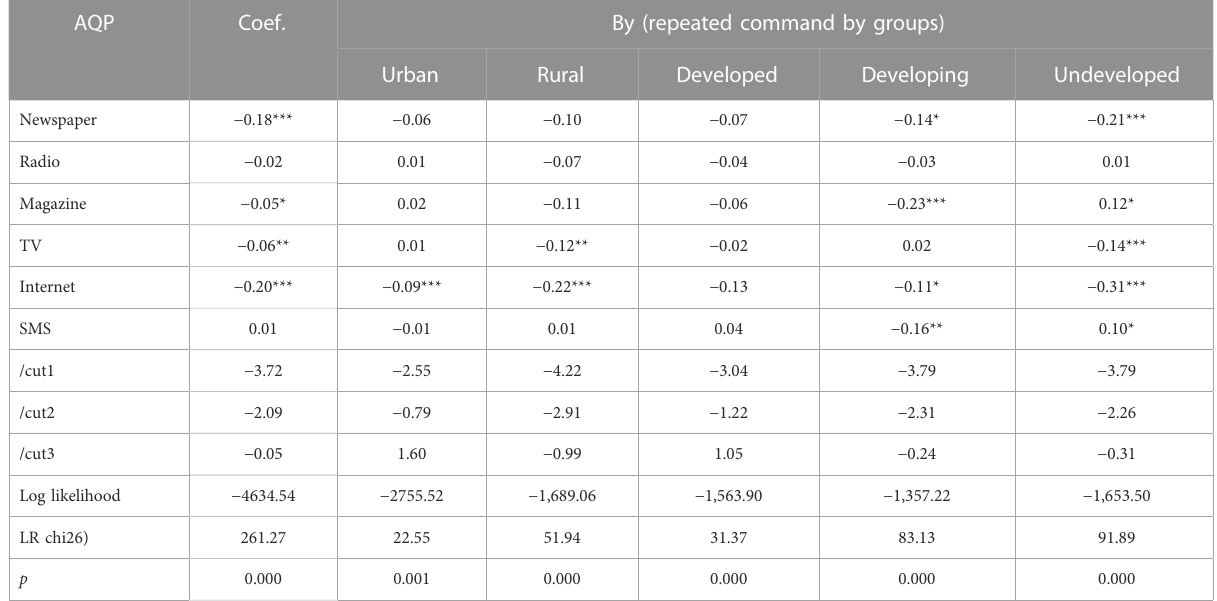
*, ** and *** denote signi fi cance at the 10%, 5%, and 1% levels, respectively.